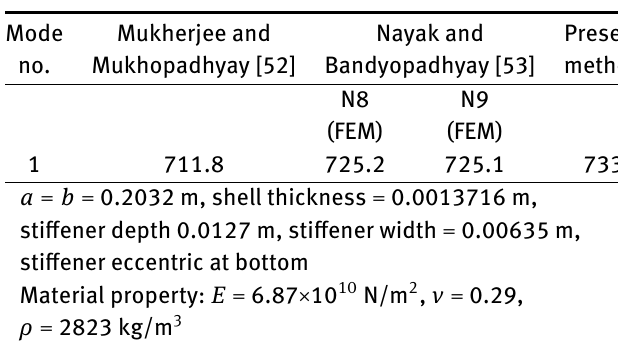
Table 1: Natural frequencies ( Hz ) of centrally stiffened clamped square plate